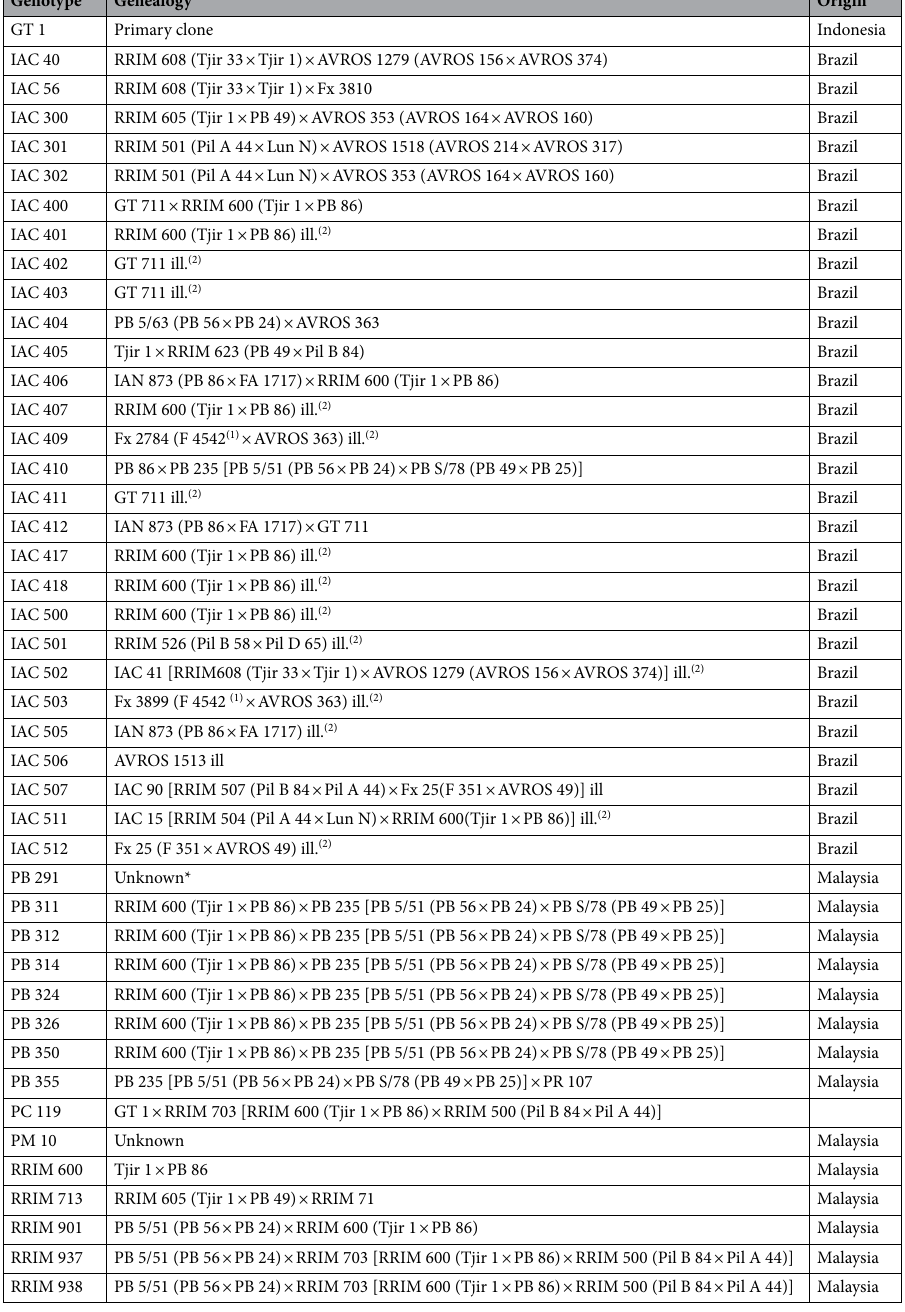
Table 3. Genealogies and origin of 44 rubber tree genotypes used in the study of genetic divergence related to natural rubber quality. Some of the genotypes are pedigree genotypes from Asia; most are from the IAC breeding program in Brazil. Both types were evaluated in Votuporanga, SP. Hevea benthamiana genotype . (2) ill., illegitimate (genotype obtained from an open pollination matrix plant). (3) Amazonian genotypes ( F Ford; FA Ford Acre, Fx Ford crossing, IAN Instituto Agronômico do Norte; RO Rondônia); São Paulo genotypes ( IAC Instituto Agronômico), Indonesian genotypes ( AVROS Algemene Vereniging Rubberplanters Oostkust Sumatra, GT Godang Tapen, PR Proefstation voor rubber, Tjir Tjirandji); Malaysian genotypes ( Lun Lunderston, PB Prang Besar, Pil Pilmoor, RRIM Rubber Research Institute of